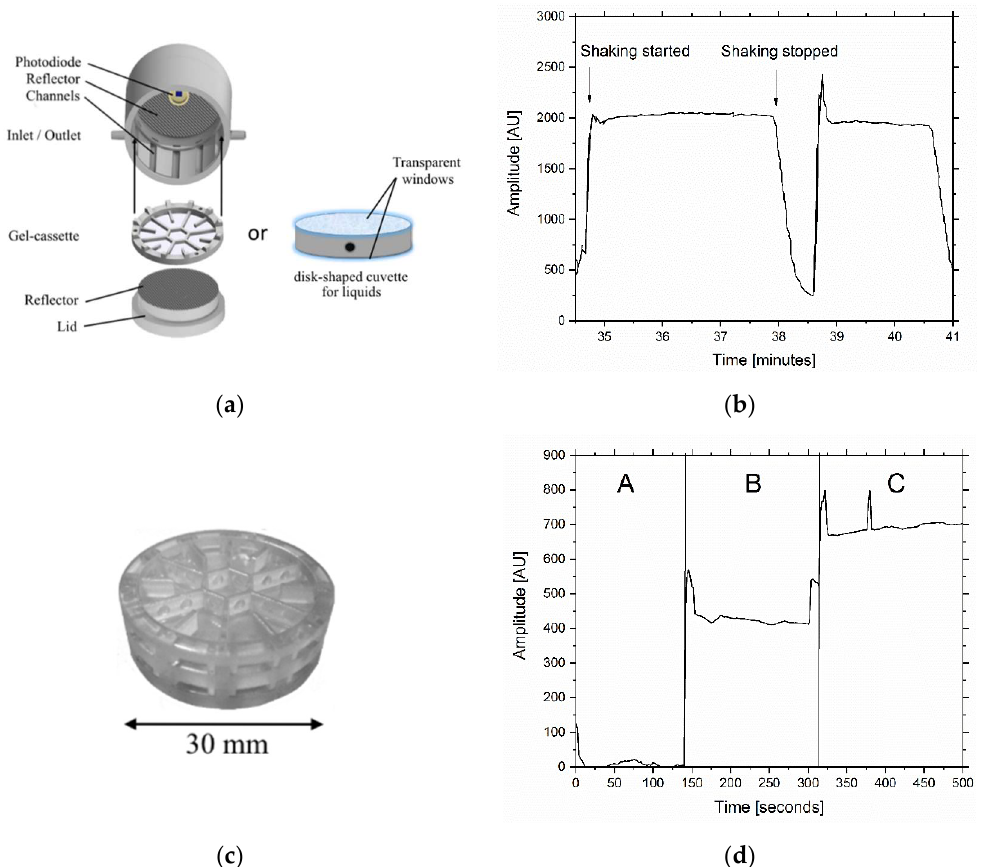
Figure 6. Scheme of prototype 2.0 and its features to measure the bioluminescence of cells in liquid broth and of immobilized cells ( a ). The cells were previously induced with 100 mg · L − 1 2,4-DNT and harvested after 3 h of growth. The liquid culture was transferred into the 3D-printed disk-shaped cuvette and placed in prototype 2.0. The whole sensor was shaken at 180 × rpm to ensure oxygen aeration ( b ). Prototype 2.0 was also capable of measuring bioluminescence of immobilized cells